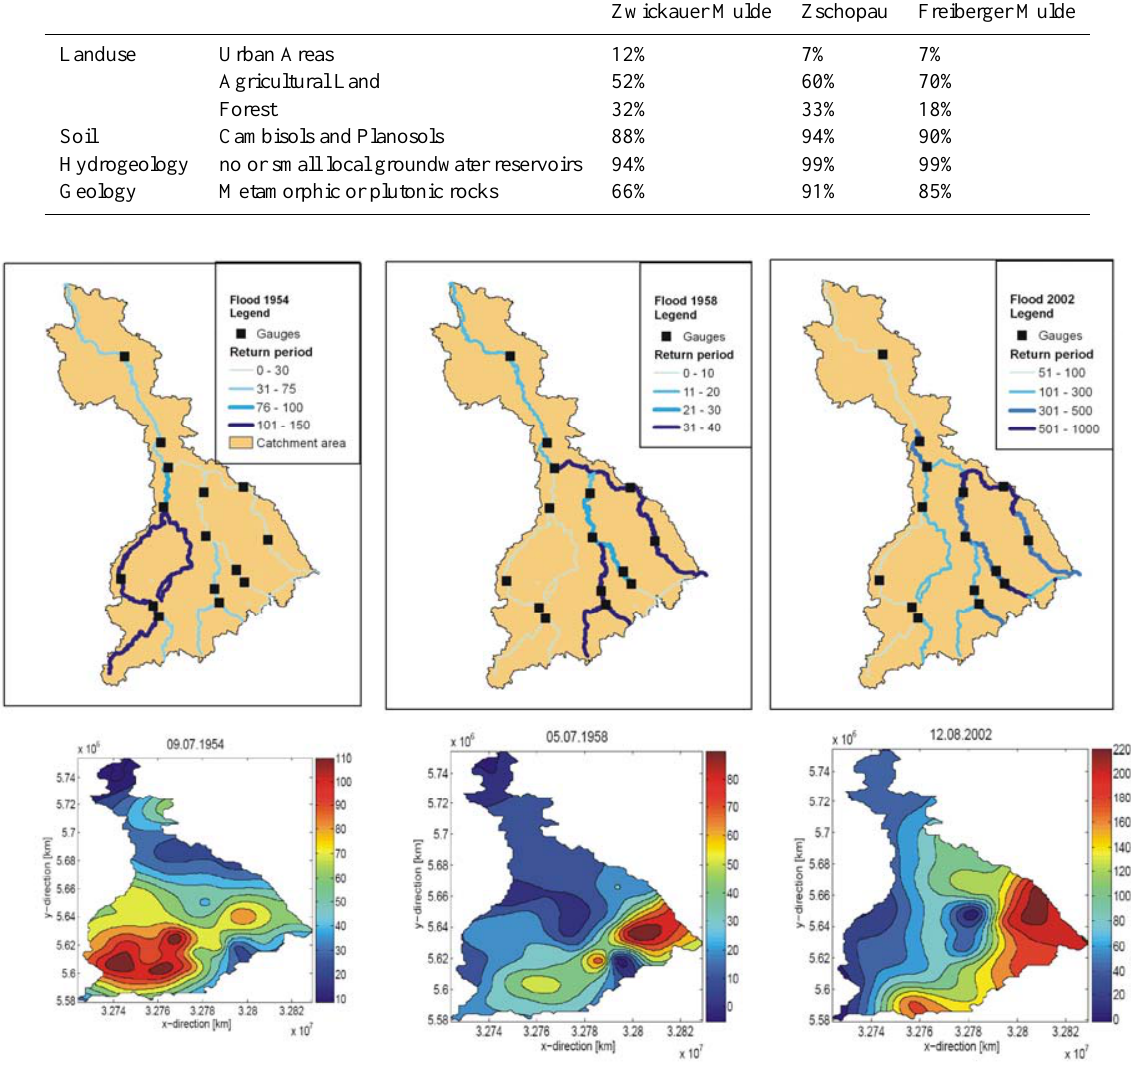
Fig. 6. Estimated return periods (GEV, L-Moments) for the floods in 1954, 1958, 2002 (period 1929–2002 (above)) and the corresponding Figure 6: Estimated return periods (GEV, L-Moments) for the floods in 1954, 1958, 2002 precipitation fields (below). Note that for a better illustration of the spatial distribution the classes of discharge return periods and precipitation amounts (period 1929 – 2002 (above)) and the corresponding precipitation fields (below). Note that for